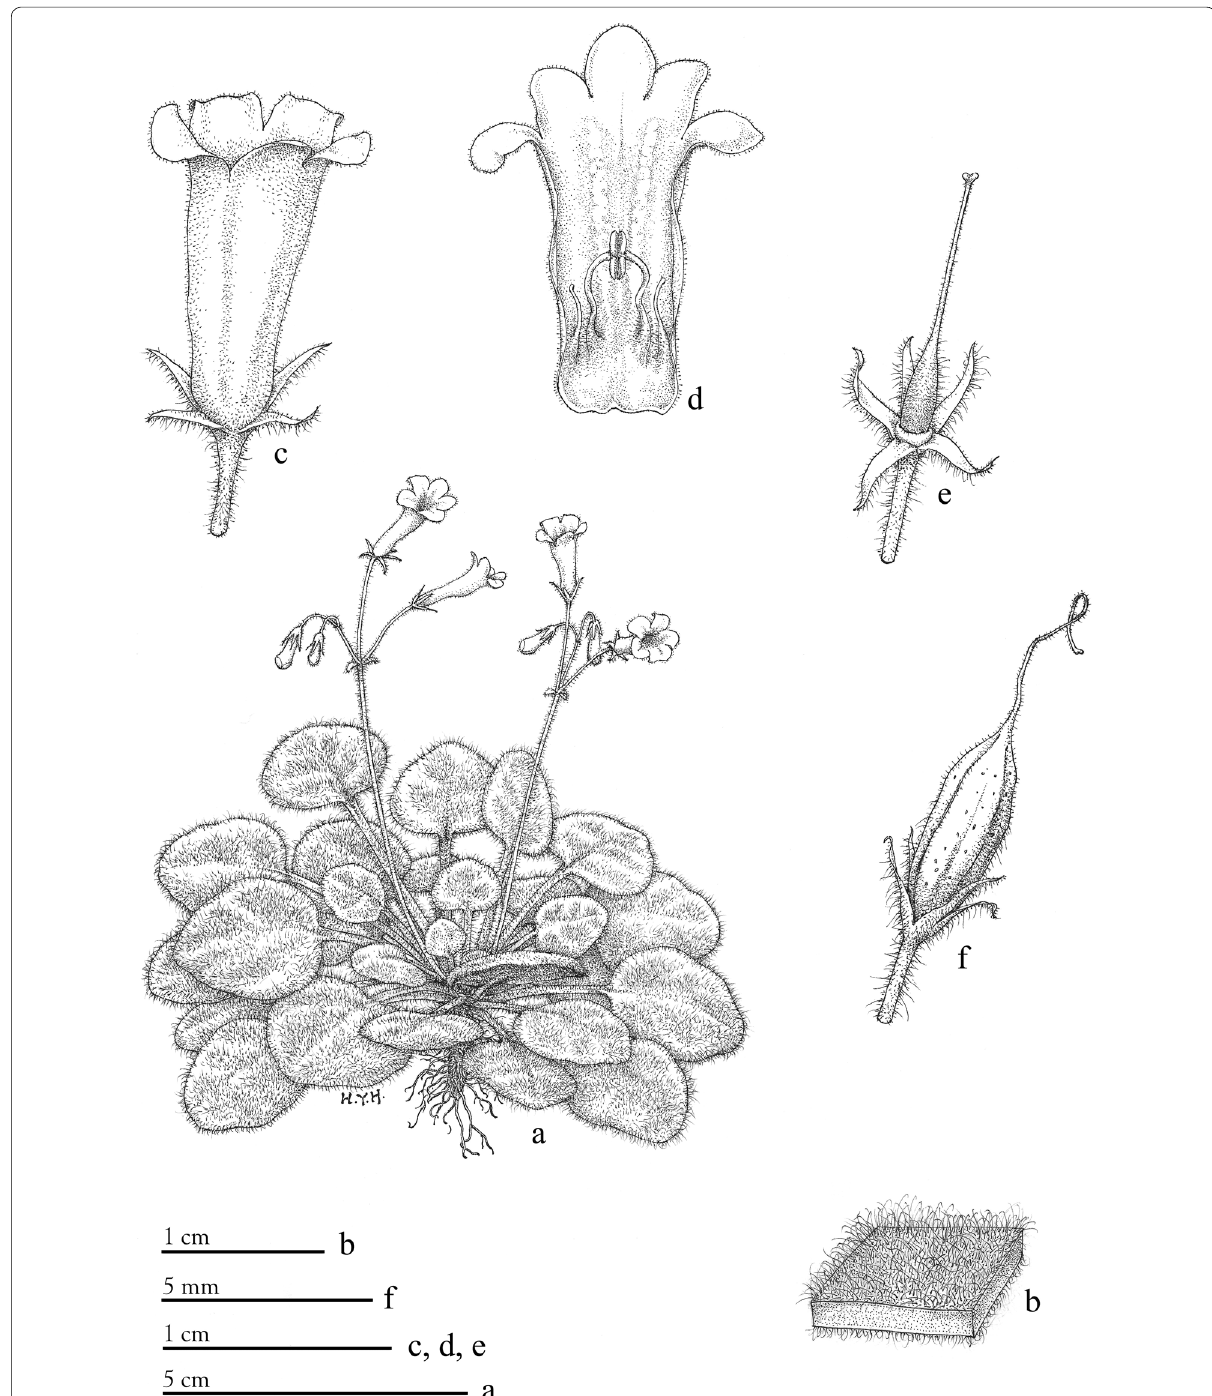
Fig. 11 Primulina chingipengii W.B.Xu & K.F.Chung. a habit, b enlarged part of blade, c flower, d corolla opened showing stamens and staminodes, e calyx, pistil and disc, f capsule. (Drawn by Han‑Yao Huang based on the